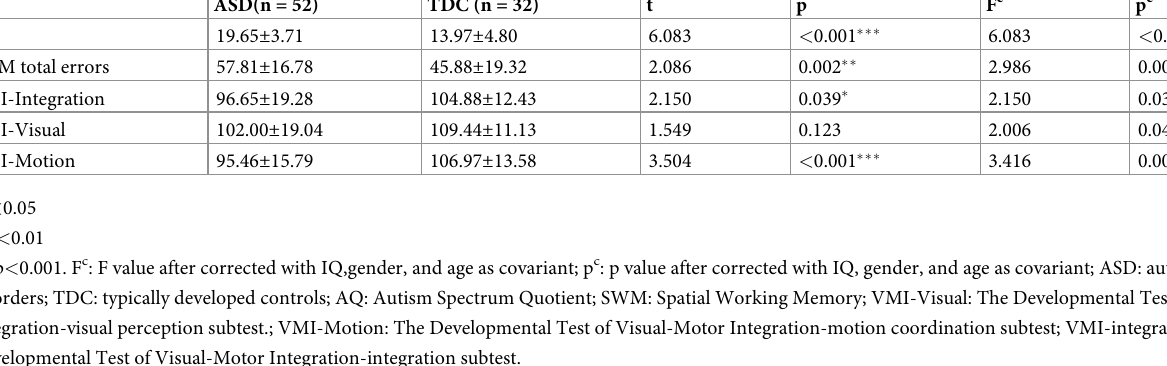
Table 2. Performance differences on Spatial Working Memory (SWM) and Berry-VMI between ASD and control. ASD(n = 52) TDC (n =